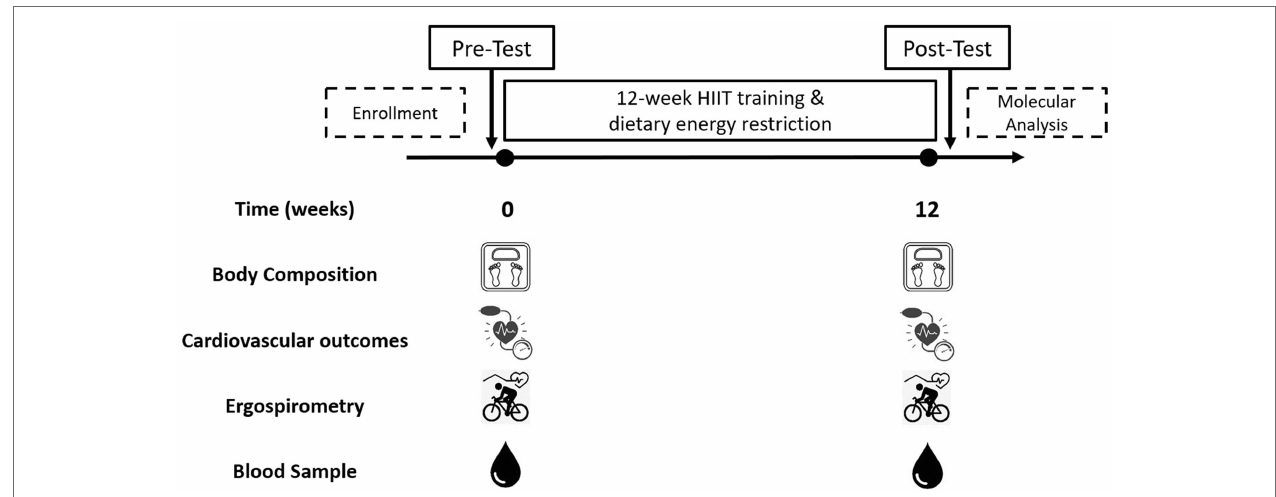
FIGURE 2 | Study protocol. Pre-test: initial assessments; Post-test: final